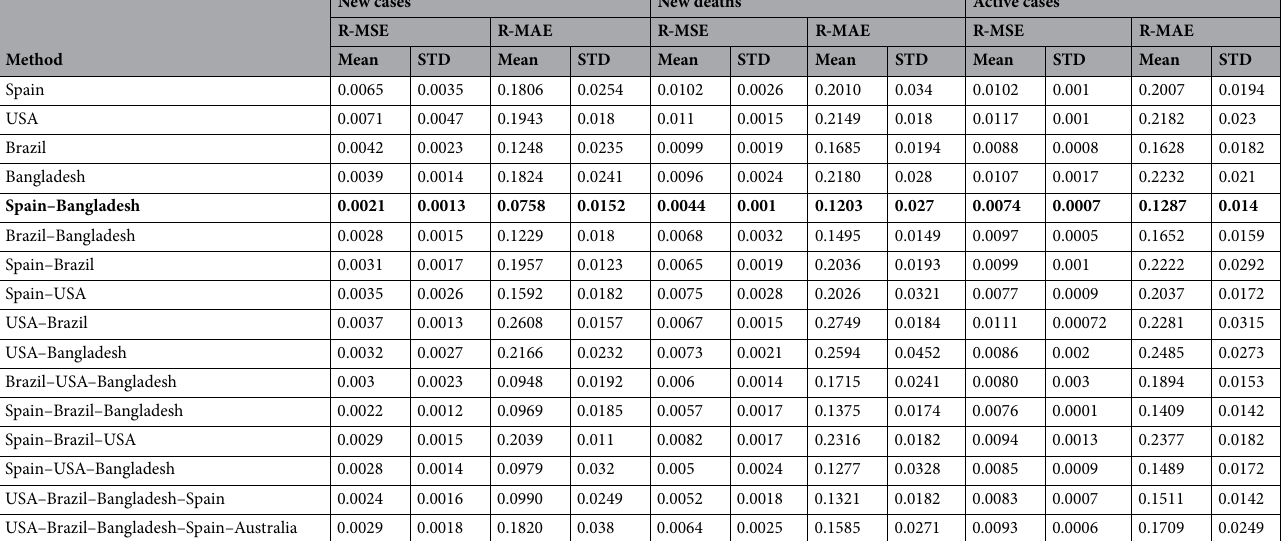
Table 4. Comparison of results i.e. i.e. Mean and Standard Deviation(STD) of 20 runs, from all possible combinations of four countries considered in this study. The GRU models have not been fine-tuned on Indian data. Best results are in